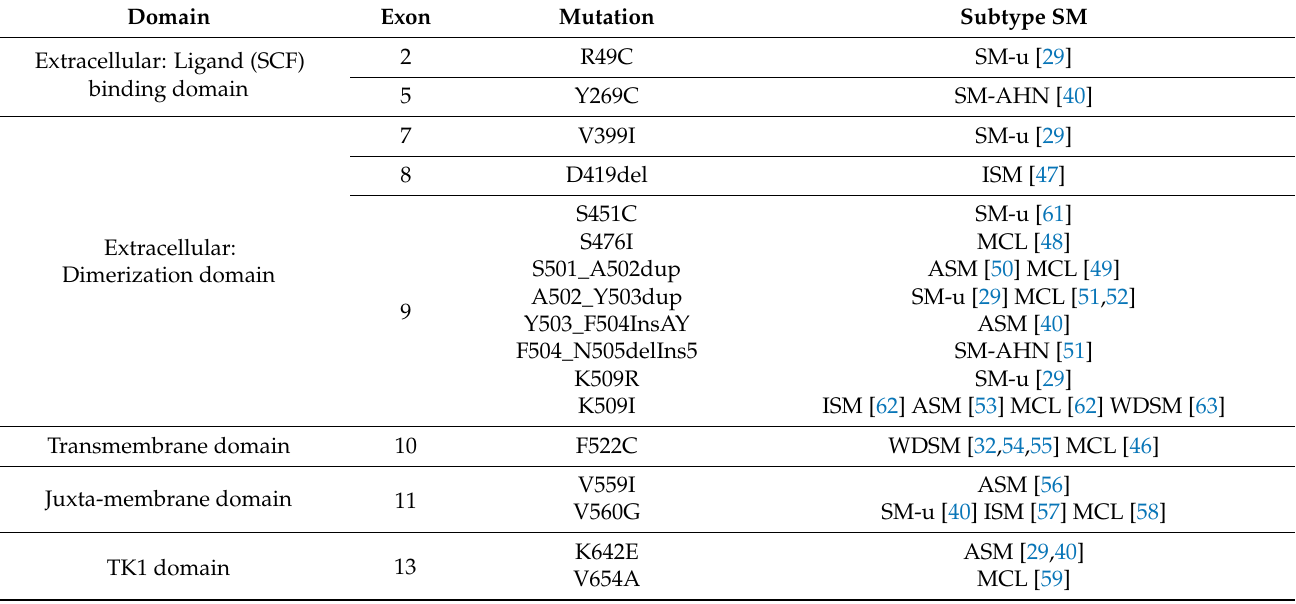
Table 1. KIT mutations other than D816V described in adult patients with systemic mastocytosis